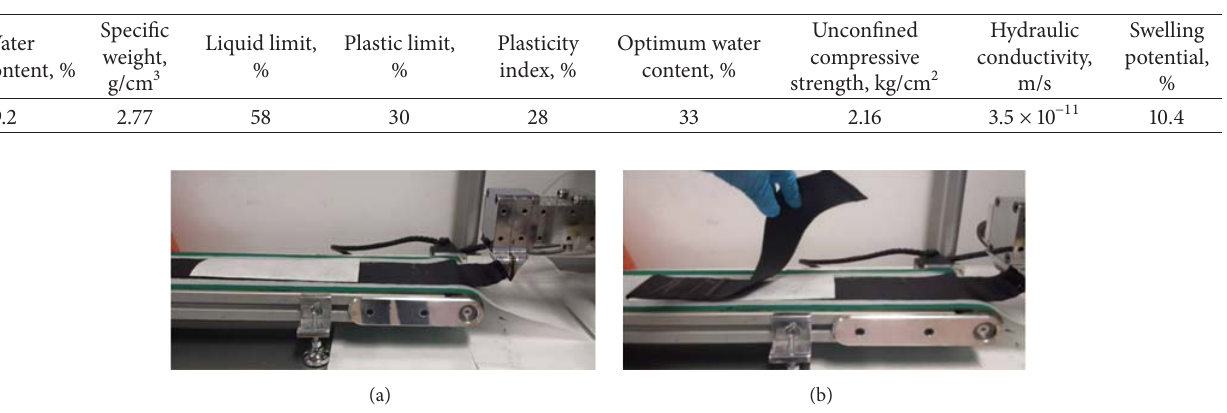
Figure 2: Geomembrane production with lab-scale extruder.